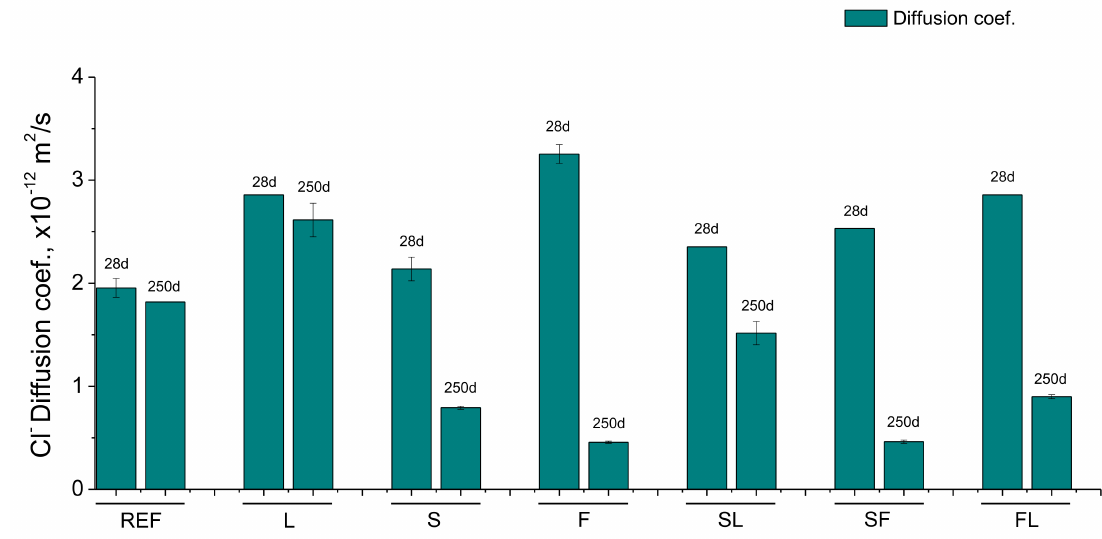
Figure 10. Results of steady-state chloride diffusion coefficient obtained from resistivity of water-saturated samples.